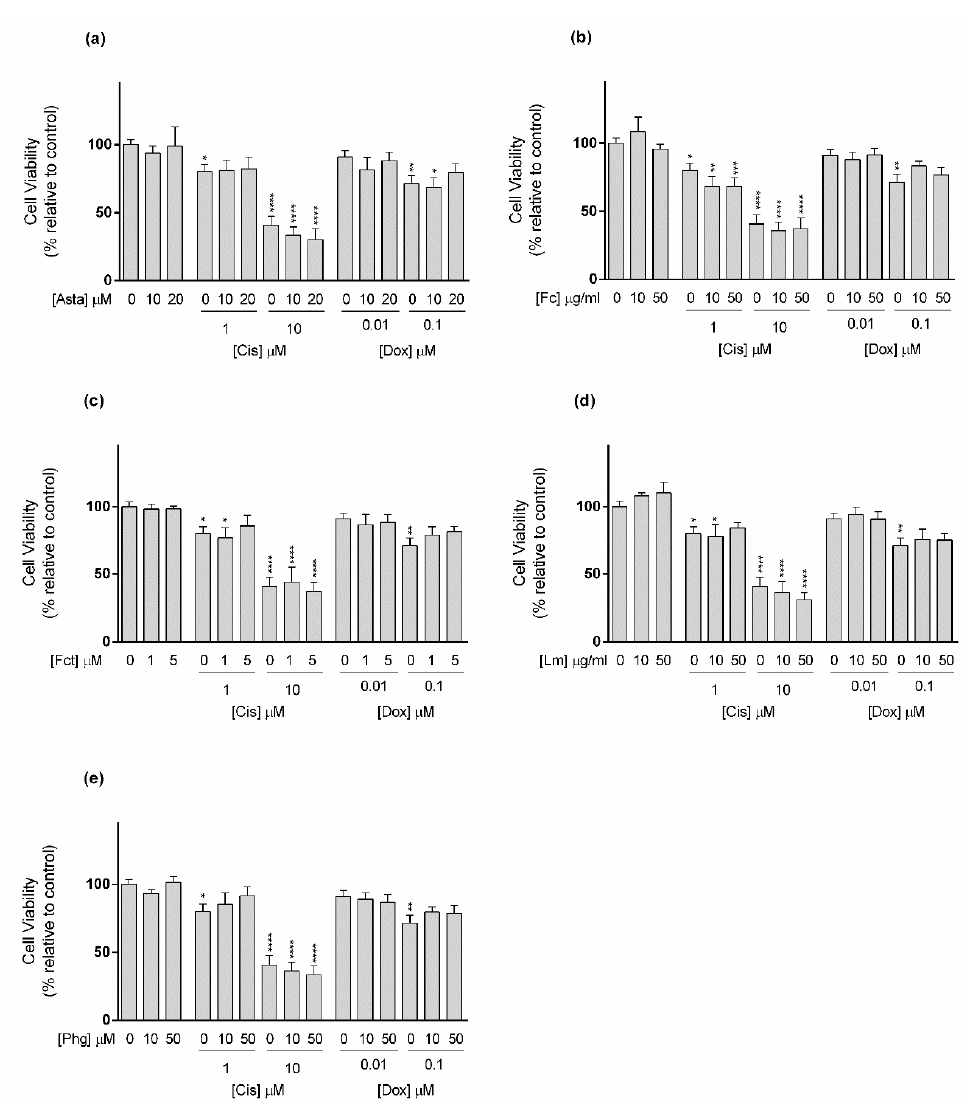
Figure 7. Cytotoxic effects of the combination of ( a ) Astaxanthin (Asta); ( b ) Fucoidan (Fc); ( c ) Fucosterol (Fct); ( d ) Laminarin (Lm); ( e ) Phloroglucinol (Phg) with the reference drugs cisplatin (Cis) and doxorubicin (Dox) assessed by the MTT assay after 72 h of exposure in MCF12A cell line cultured in monolayer. Control corresponds to cells incubated with medium containing 0.1% DMSO. The percentages of cell viability are relative to the control and presented as mean + standard deviation of six independent experiments (each in triplicate). (* p < 0.05, ** p < 0.01; *** p < 0.001, **** p <